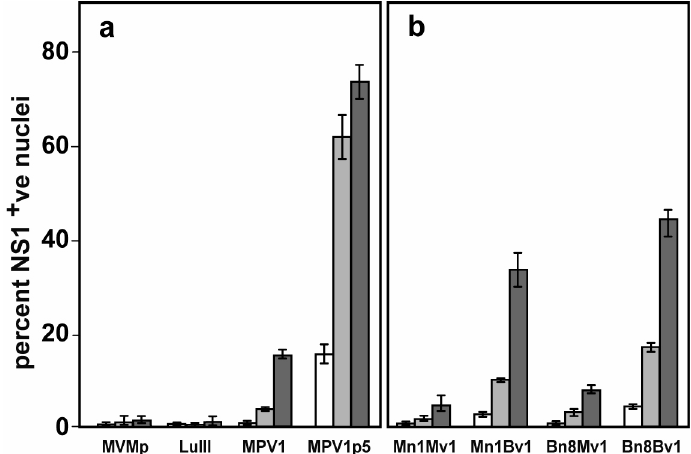
Figure 1. Infection of B16F10 cells with individual protoparvovirus strains. B16F10 cells were infected, at 5-fold increasing multiplicities, with panel ( a ) MVMp, LuIII, and uncloned Mouse Parvovirus 1 (MPV1) stocks, and panel ( b ) viruses derived from MPV1 founder infectious clones. Viruses derived from the founder clones, described in Section 3.2 below, are named for the originating virus stock, “M” for the parental MPV1 or “B” for the B16F10-passaged virus MPV1p5, and “n” for the NS/VP1 region or “v” for the VP2 region, followed by the number of the sample from which it was derived, as shown in Figures 2 and 3 below. White bars = 200, light grey bars = 1000 and dark grey bars = 5000 genome equivalents per cell. Twenty-four hours after infection, cells were fixed, permeabilized, stained for NS1, and analyzed by flow cytometry, as described in the Methods section. Error bars represent the standard deviation for duplicate infections.